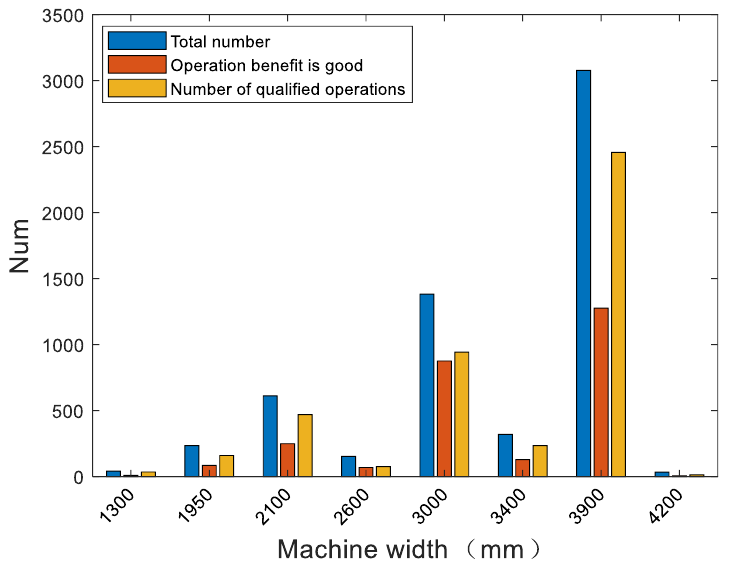
Figure 10. Operational benefits histogram of 1504 agricultural machinery with different width ma- chines.